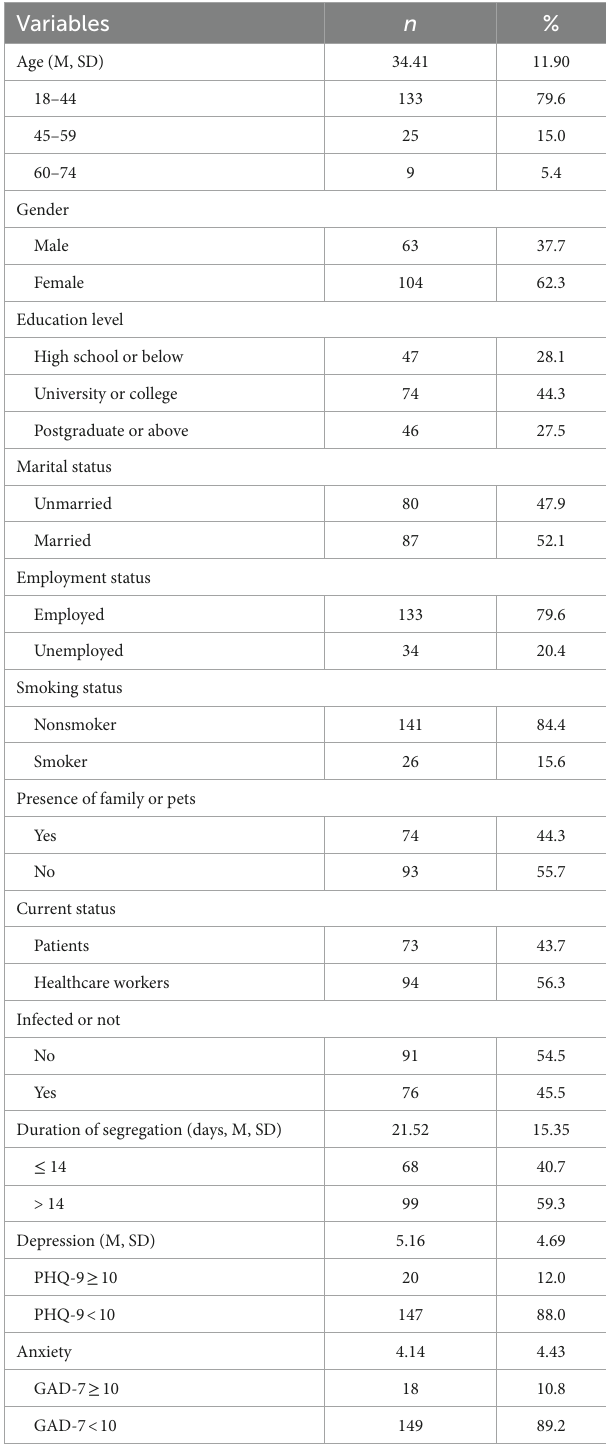
TABLE 2 Correlations between depression, anxiety, perceived stress, self-efficacy and perceived social